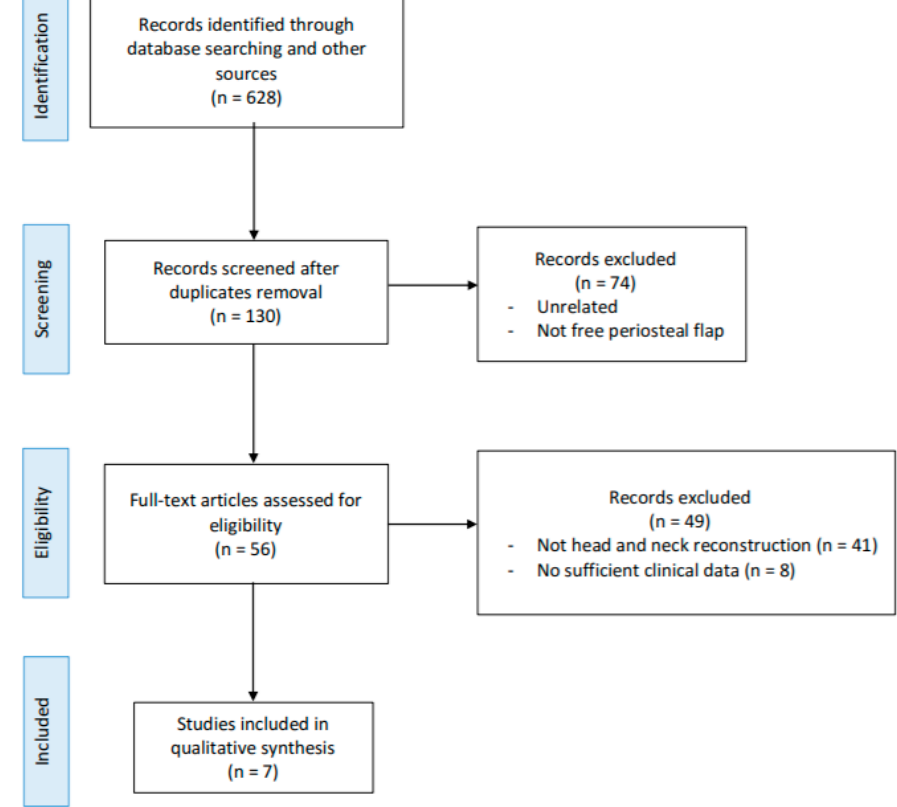
Figure 1. Preferred Reporting Items for Systematic Reviews and Meta-Analyzes 2009 flow diagram.